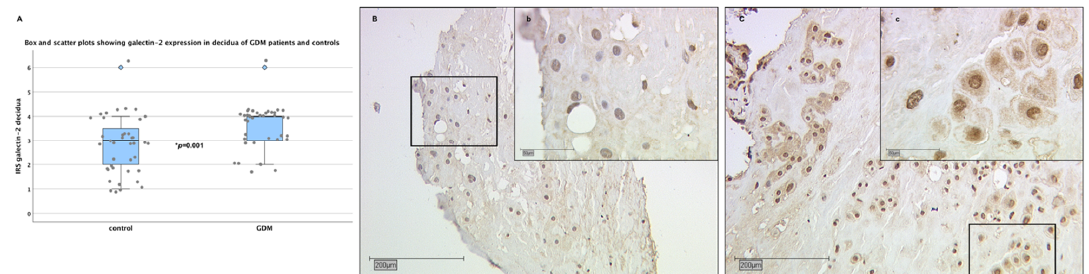
Figure 3. Galectin-2 expression in the maternal decidua of control and GDM placentas. Box and scatter plots ( A ) showing the IRS for galectin-2 expression in decidua to be significantly higher in GDM placentas ( p = 0.001). See Figure 1 for a detailed box plot explanation. Pictures show representative slides for immunohistochemical staining of galectin-2, in the maternal decidua of the control ( B ) and the GDM ( C ) placentas. The scale bar equals 200 μm in full size images and 50μm in inserts. Black rectangles indicate the section seen at a higher magnification (minuscular letters).